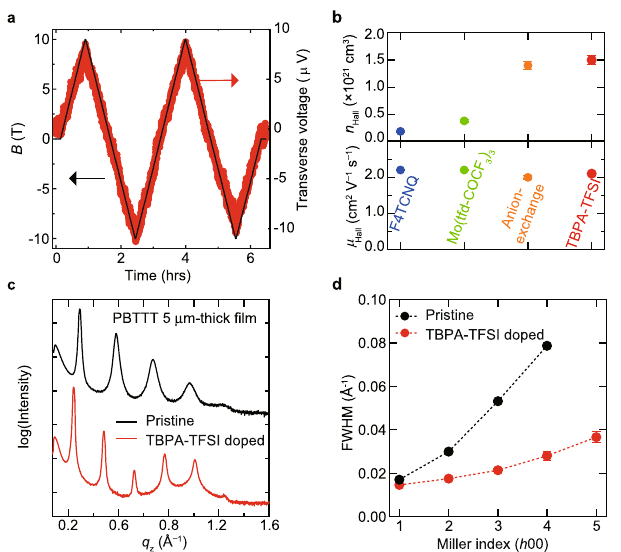
Fig. 4 Hall effect measurements and homogeneity of doping effect. a Hall voltages and the applied magnetic fi eld B in the out-of-plane direction and ( b ) Hall carrier density n H derived from the inverse Hall coef fi cient n H ¼ ð eR Þ (cid:2) 1 and Hall mobility μ μ = R σ for PBTTT thin fi lms H estimated from H H H doped with F4TCNQ (blue), Mo(tfd-COCF 3 ) 3 (green), anion-exchange (orange), and TBPA-TFSI (red) at 240 K. The error bars in n H and μ H represent uncertainties in extracting the Hall voltage from the fi tting and the thickness of the polymer thin fi lms and represent one standard deviation. c Out-of-plane XRD measurements of a PBTTT fi lm with a thickness of 5 μ m before and after TBPA-TFSI doping. d Miller